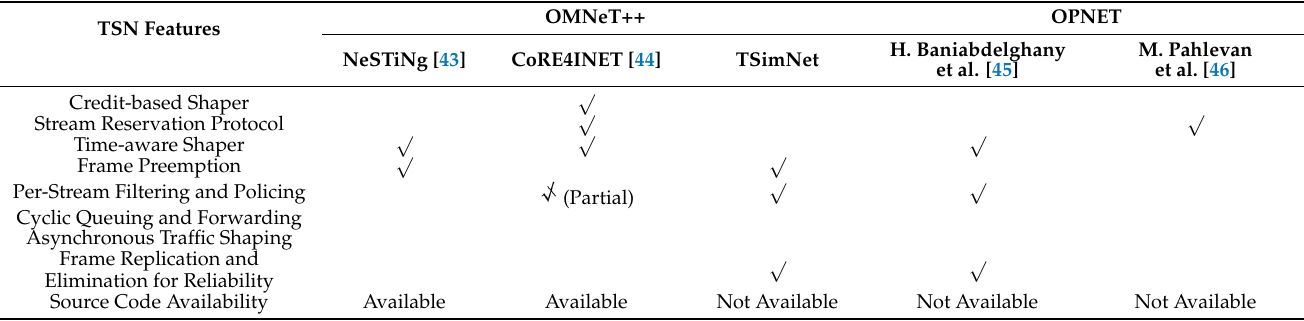
Table 2. TSN features implemented by each simulation environment.